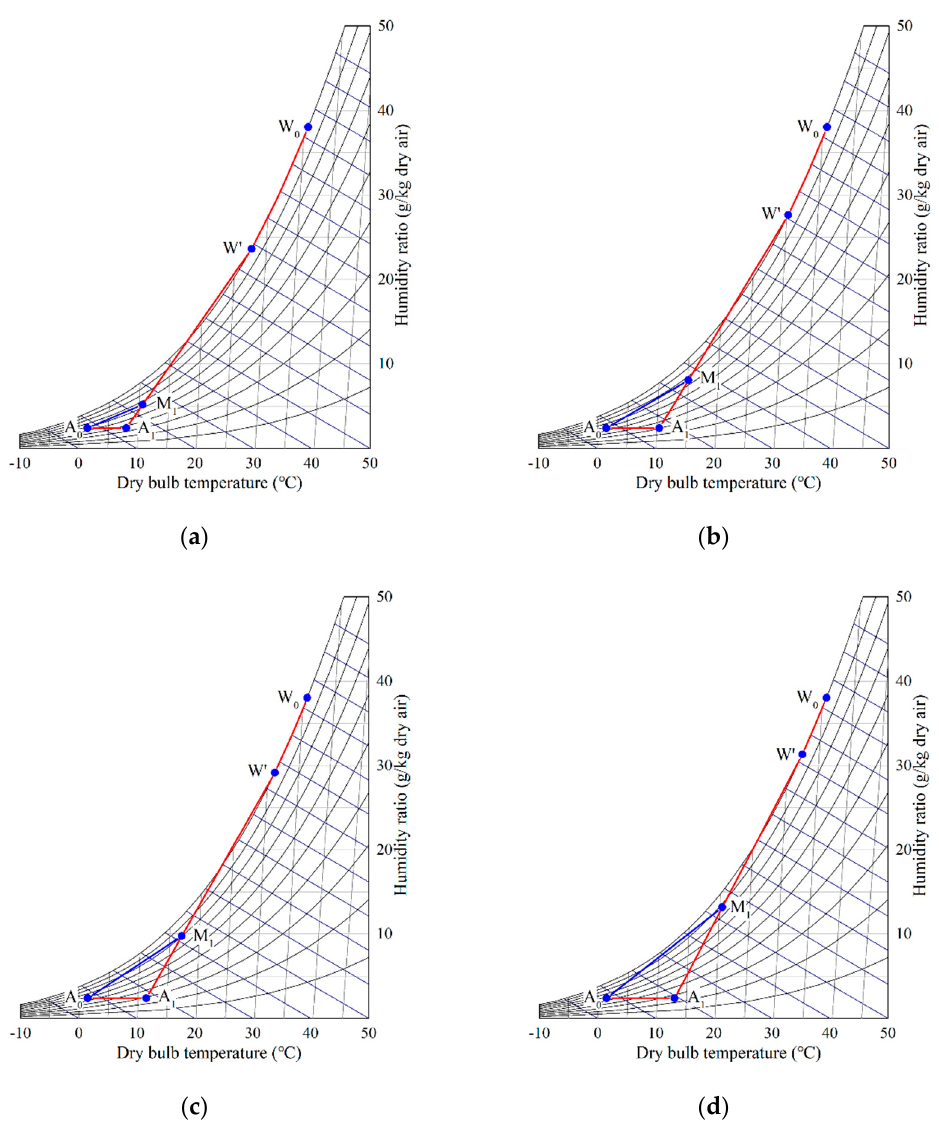
Figure 10. Thermodynamic process with di ff erent G values at N = 8. ( a ) G = 800 m 3 / h. ( b ) G = 1500 m 3 / h. Atmosphere 2019 , 10 , x FOR PEER REVIEW 13 of 15 ( c ) G = 2000 m 3 / h. ( d ) G = 3000 m 3 / h.